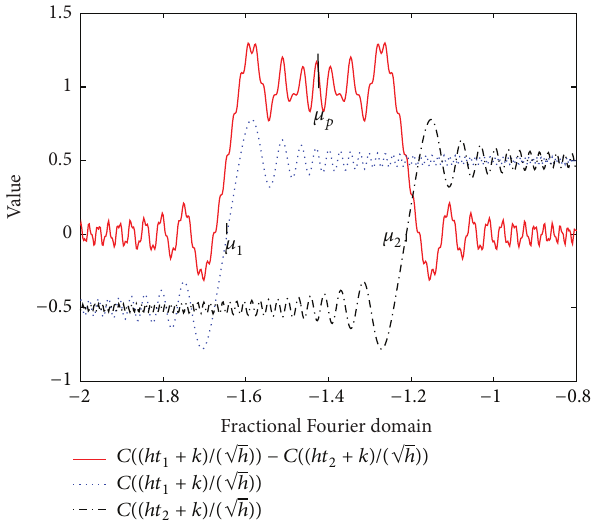
Figure 6: The main lobe formed by the subtraction of the two Fresnel cosine integrals in the FrFT of a received signal.